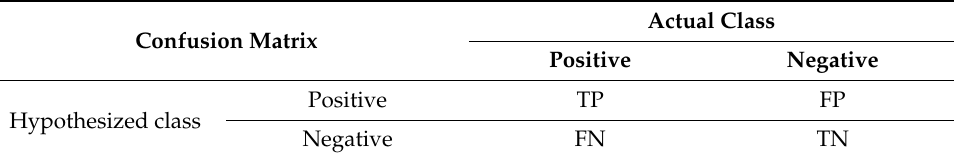
Figure 4. Test dataset and classification results of the ADAYSN-based machine-learning methods. Table 2. The confusion matrix for binary